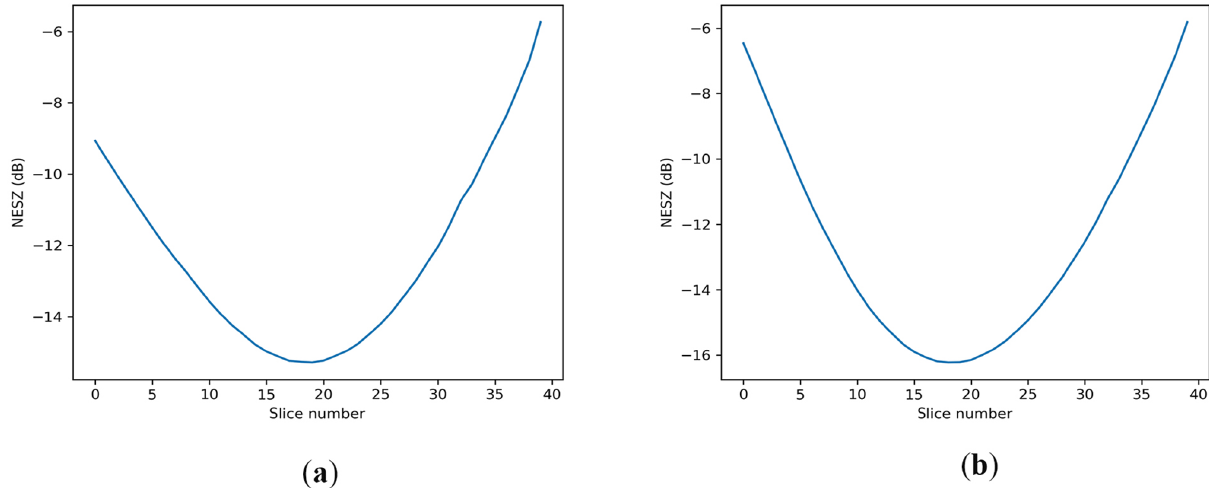
Figure 3. SCAT NESZ distribution as a function of slice number. (a) Ku-band HH polarization. (b) Ku-band VV